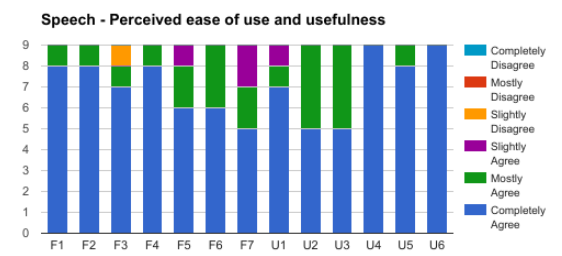
Fig. 13. Individual answers - Luminosity